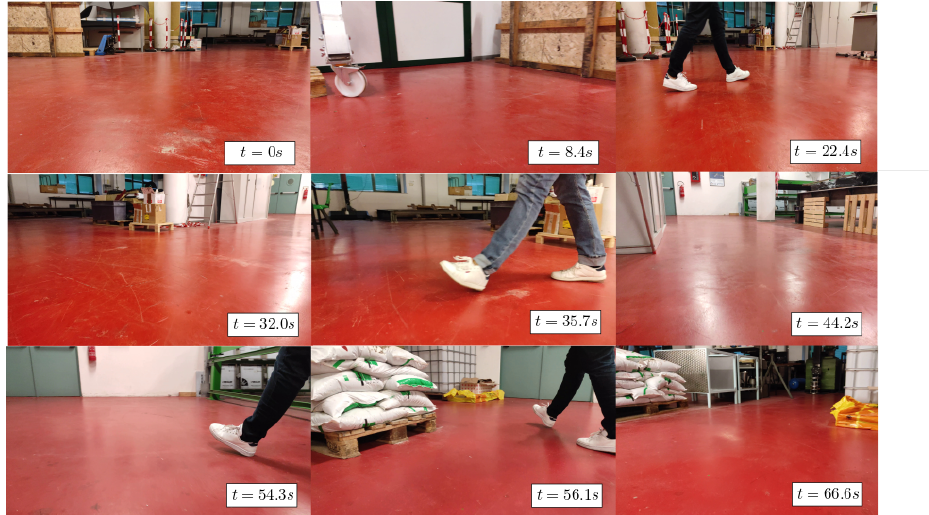
Figure 16. Extracted video frames from the robot camera during its point-to-point motion in the presence of moving